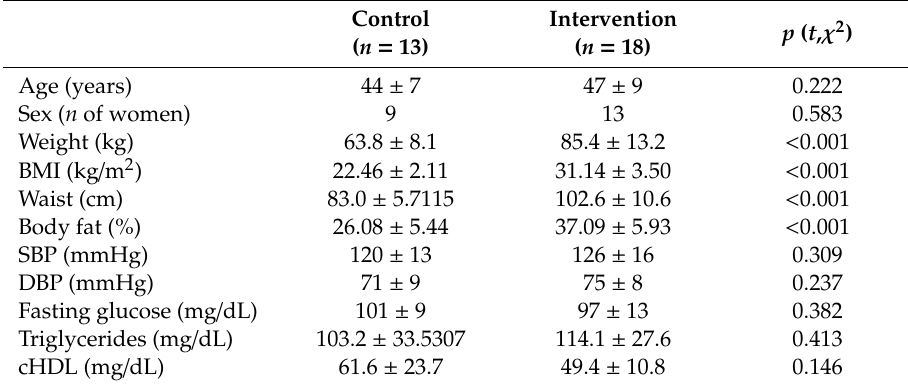
Table 1. Subjects’ characteristics at